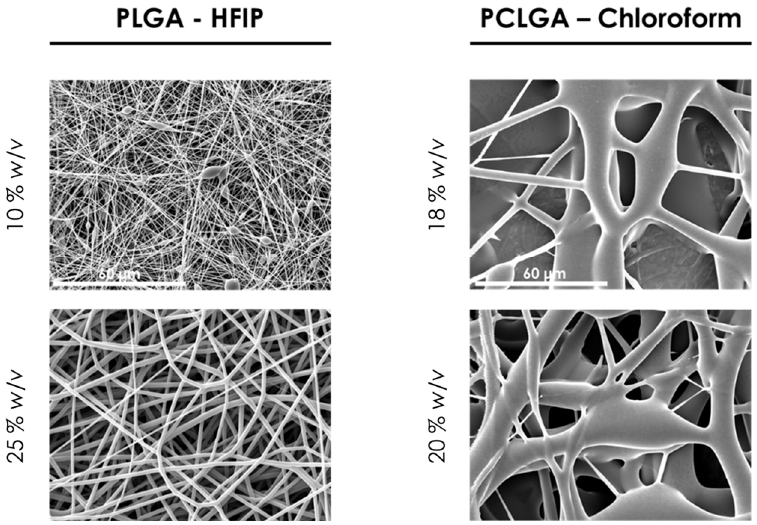
Figure 2. SEM images of PLGA (10 and 25% w/v in HFIP) and PCLGA (18 and 20% w/v in chloroform) at 2 mL/h, 17 kV and 13 cm. All images share the same scale bar: 60 μ m.